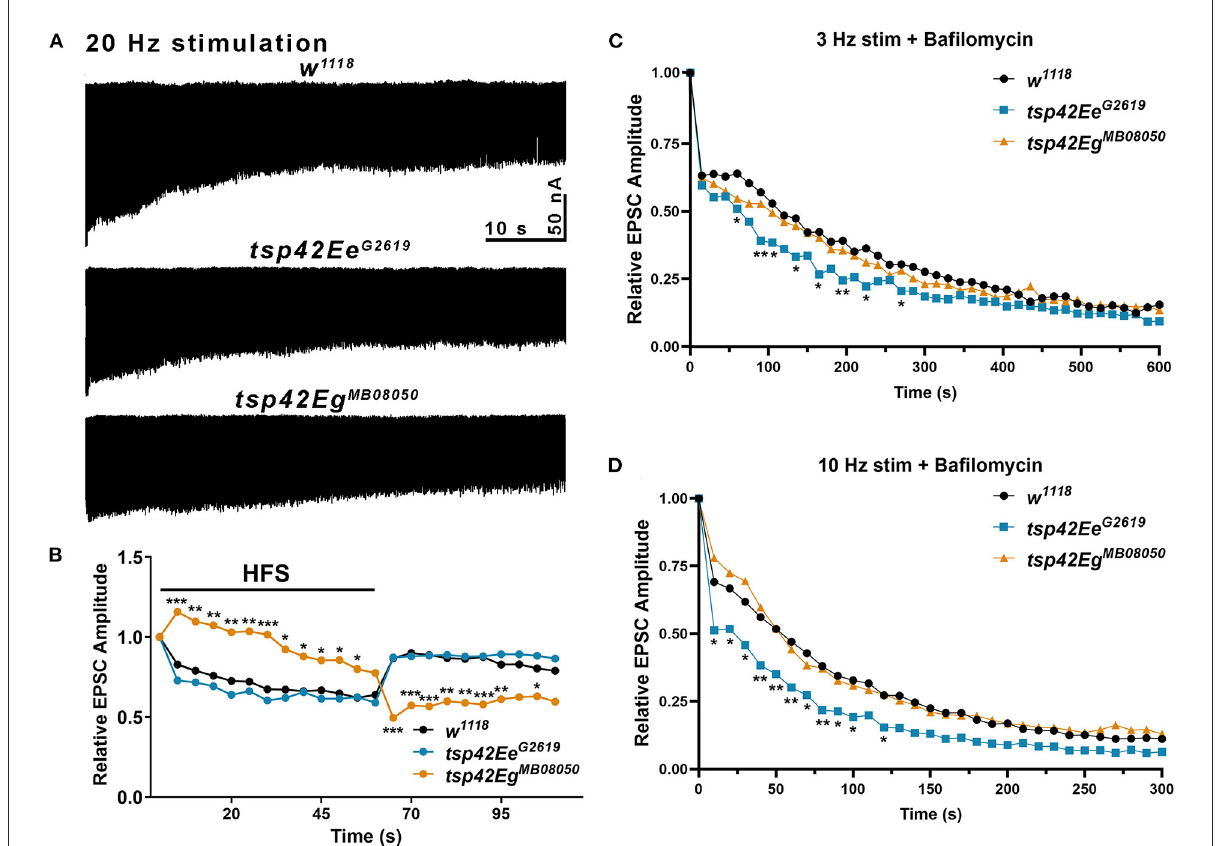
FIGURE5 Tsp42Ee and Tsp42Eg differentially affect evoked responses to high frequency stimulation and synaptic vesicle pools. (A) Representative recordings from animals during 20Hz stimulation in HL-3 + 1.0mM Ca 2 + . (B) Relative EPSC amplitudes (to the first stimulus) over time during both 20Hz stimulation (first 60s) and the recovery period (final 50s). Tsp42Eg MB 08050 mutants showed increased EPSC amplitudes during the first 55s of 20Hz stimulation but decreased amplitudes during the recovery period as determined by a two-way ANOVA ( F (39,858) = 15.27, p